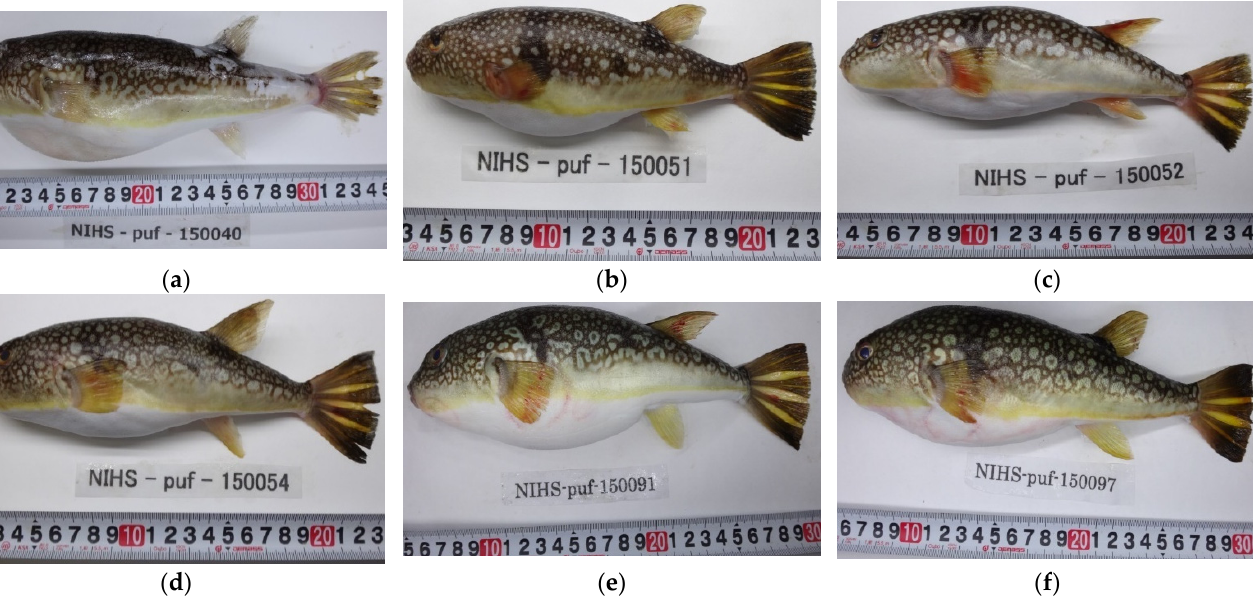
Figure 4. The LC–MS/MS MRM ( m/z 320.2 > m/z 162.1 and m/z 320.2 > m/z 302.0) chromatograms of reference tetrodotoxin and a representative sample. ( a , b ), TTX reference solution (10 ng/mL); ( c , d ), flesh and skin samples, respectively, of spec- imen NIHS-140040. Analytical columns used were Inertsil Amide (3 μ m, 2.1 × 75 mm) for ( a , c ), and InertSustain Amide (3 μ m, 2.1 × 75 mm) for ( b , d ).